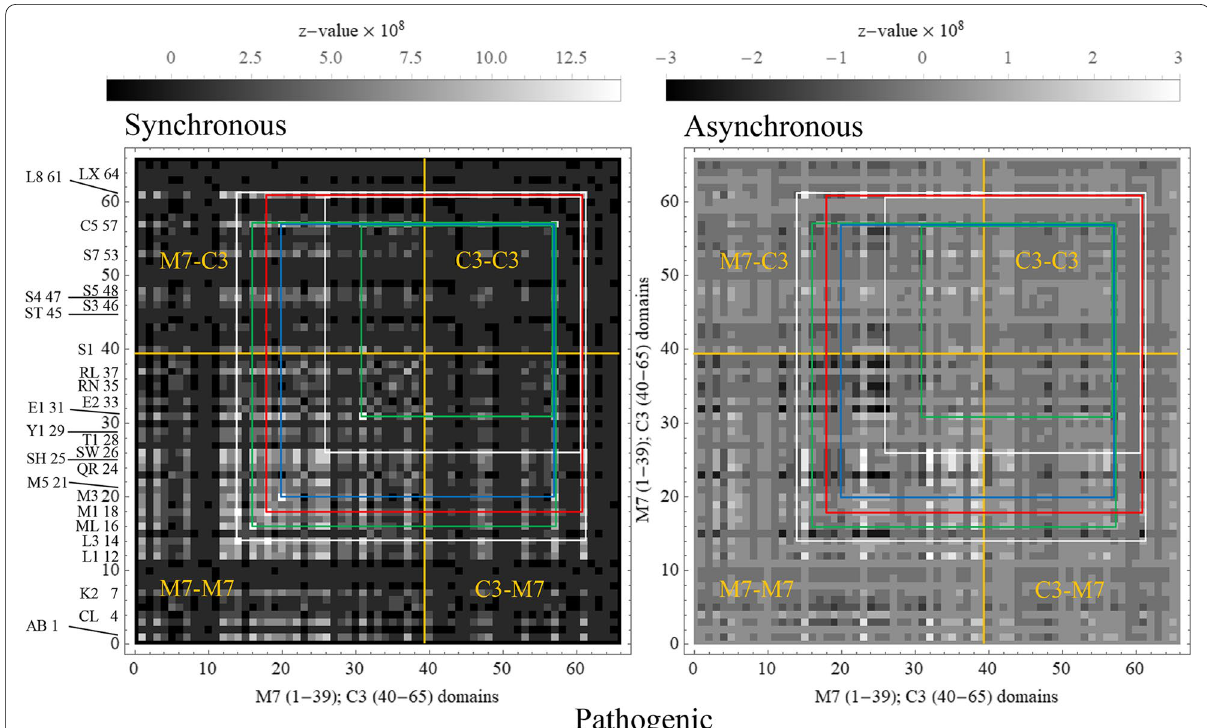
Fig. 4 βmys/MYBPC3 complex correlation maps for pathogenic outcomes implied by 2D-CG. Synchronous (left) or asynchronous (right) maps have axes identical for both dimensions representing βmys (M7 1-39) followed by MYBPC3 (C3 40-65) domains. Domain index is linked to its two-letter code and protein sequence in Supplementary Table S1. Two-letter codes for domains label some indices on the leftmost axis in the figure. Intensities (z-values) are indicated numerically by the grayscale. Regions defined by vertical and horizontal orange lines at the interface of pixels 39-40 separate intra-protein cross-peaks (within regions M7-M7 and C3-C3) from inter-protein cross-peaks (within regions M7-C3 and C3-M7). Intensity peaks along the diagonal in the synchronous map are autocorrelated probabilities for each domain. Correlation squares link the 6 most significant off-diagonal co-domain coordinates falling within the M7-C3 and C3-M7 regions. They are white, green, red, blue, for different βmys domains then repeating color sequence as